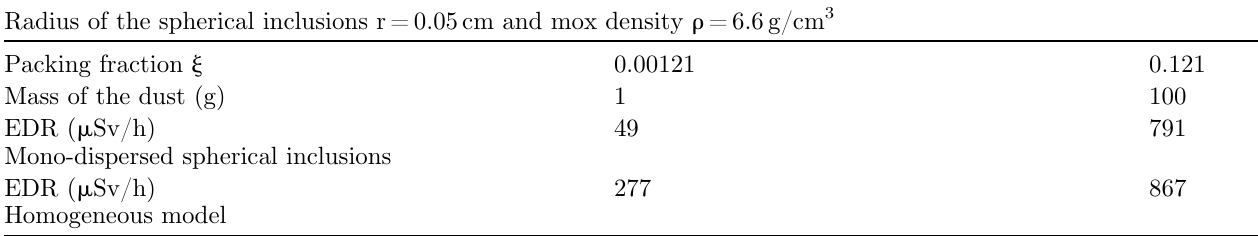
Table 4. Equivalent dose rate calculated for different packing